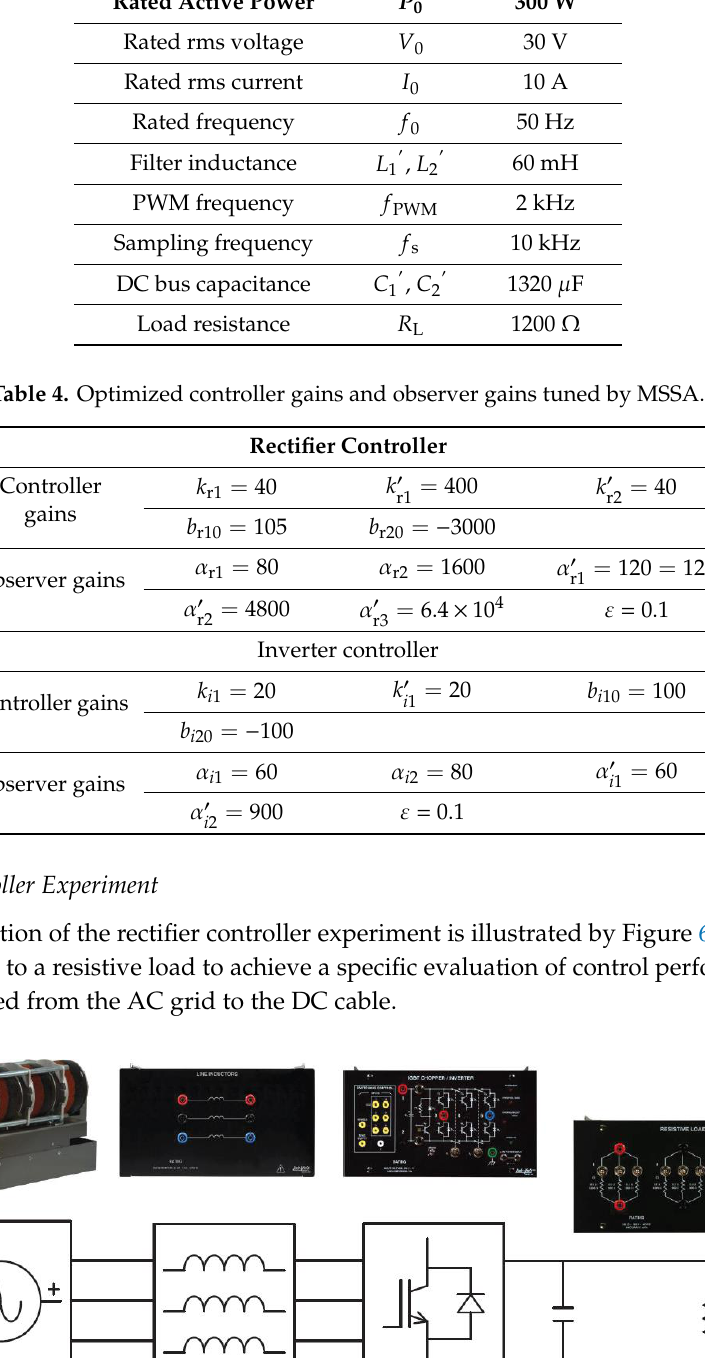
Table 3. System parameters used in the experiment.